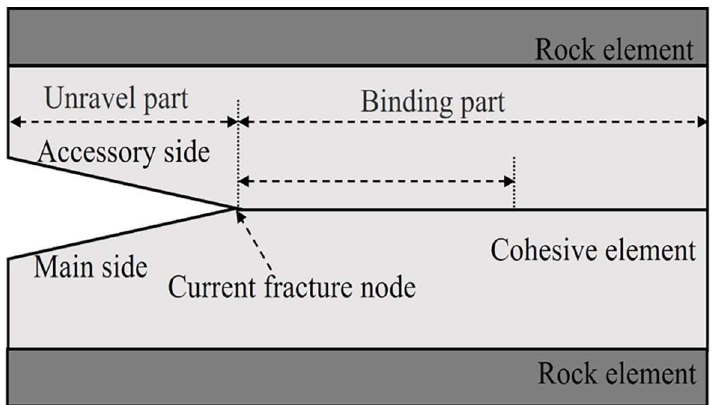
Figure 3. Fracture propagation in the cohesive unit.